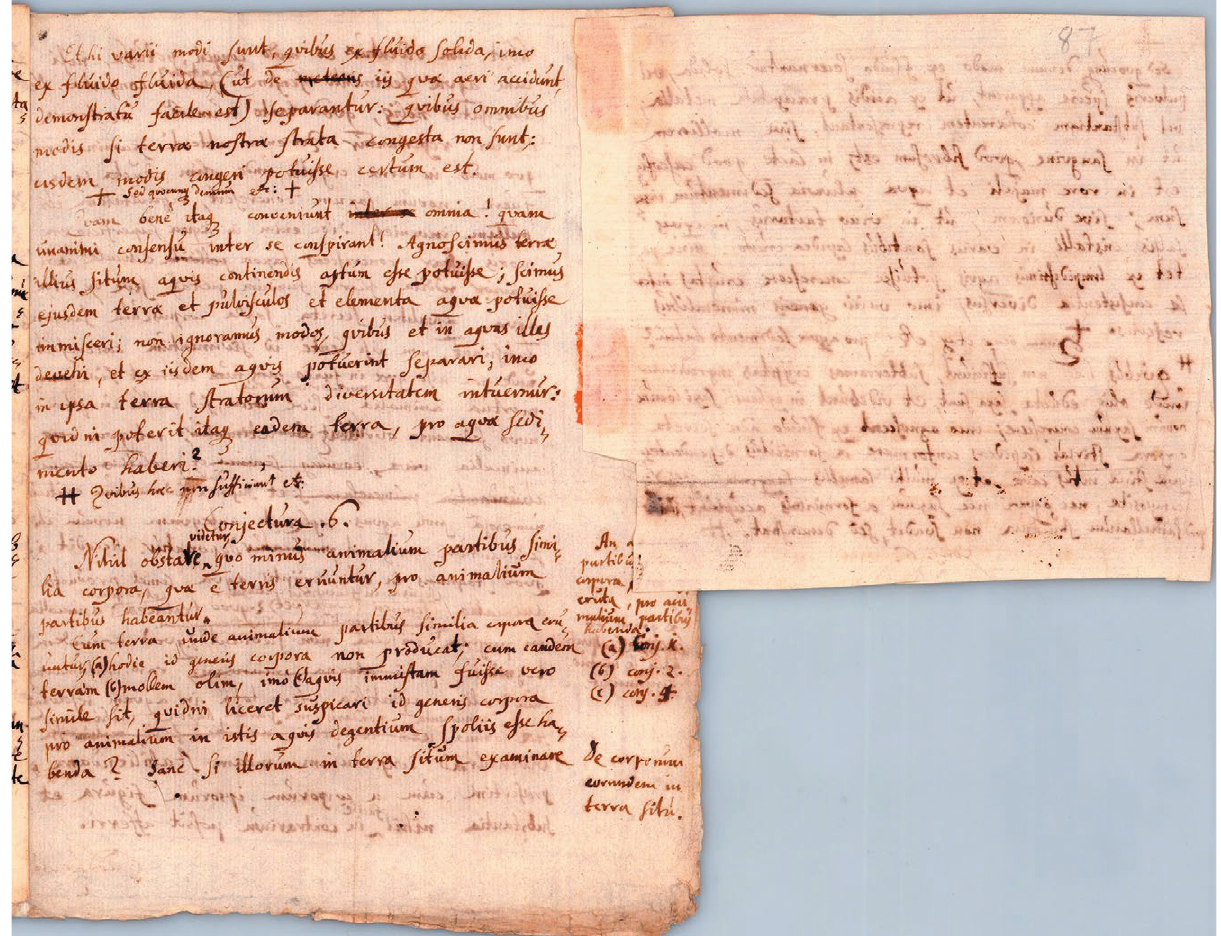
Figure 5. Near the end of Conjecture 5 in the printer’s manuscript of Canis carchariae , the sign + ... + indicates where to make an insertion from a glued-in sheet. See Fig. 6 for the recto of the glued-in sheet. Illustrations by the Royal National Library, Copenhagen, reproduced with